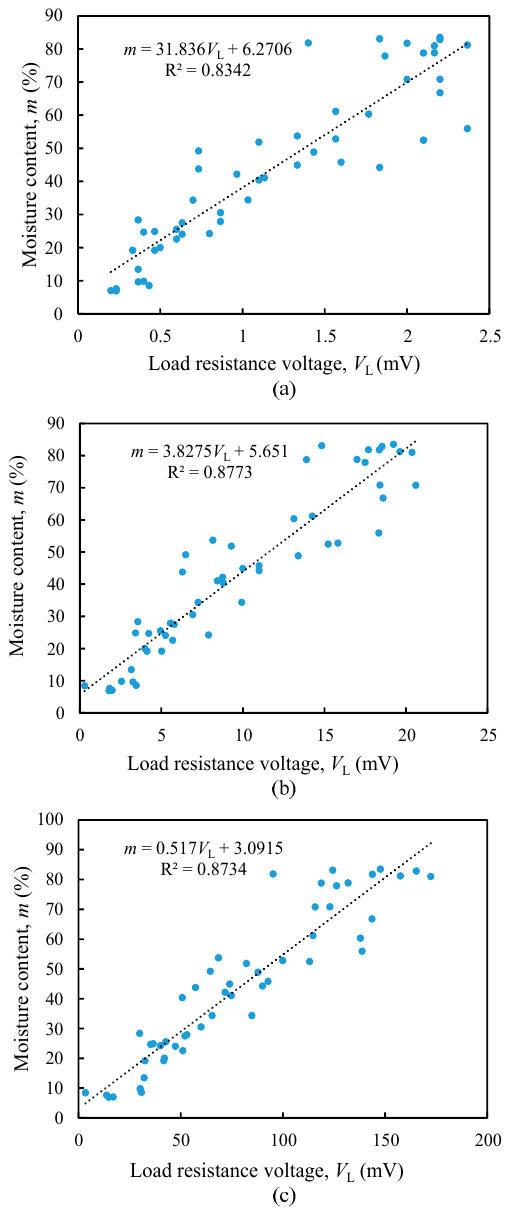
Figure 7. The prediction scatter plot between load resistance voltage and moisture content, ( a ) 10 Ω , ( b ) 100 Ω , and ( c ) 1 k Ω .